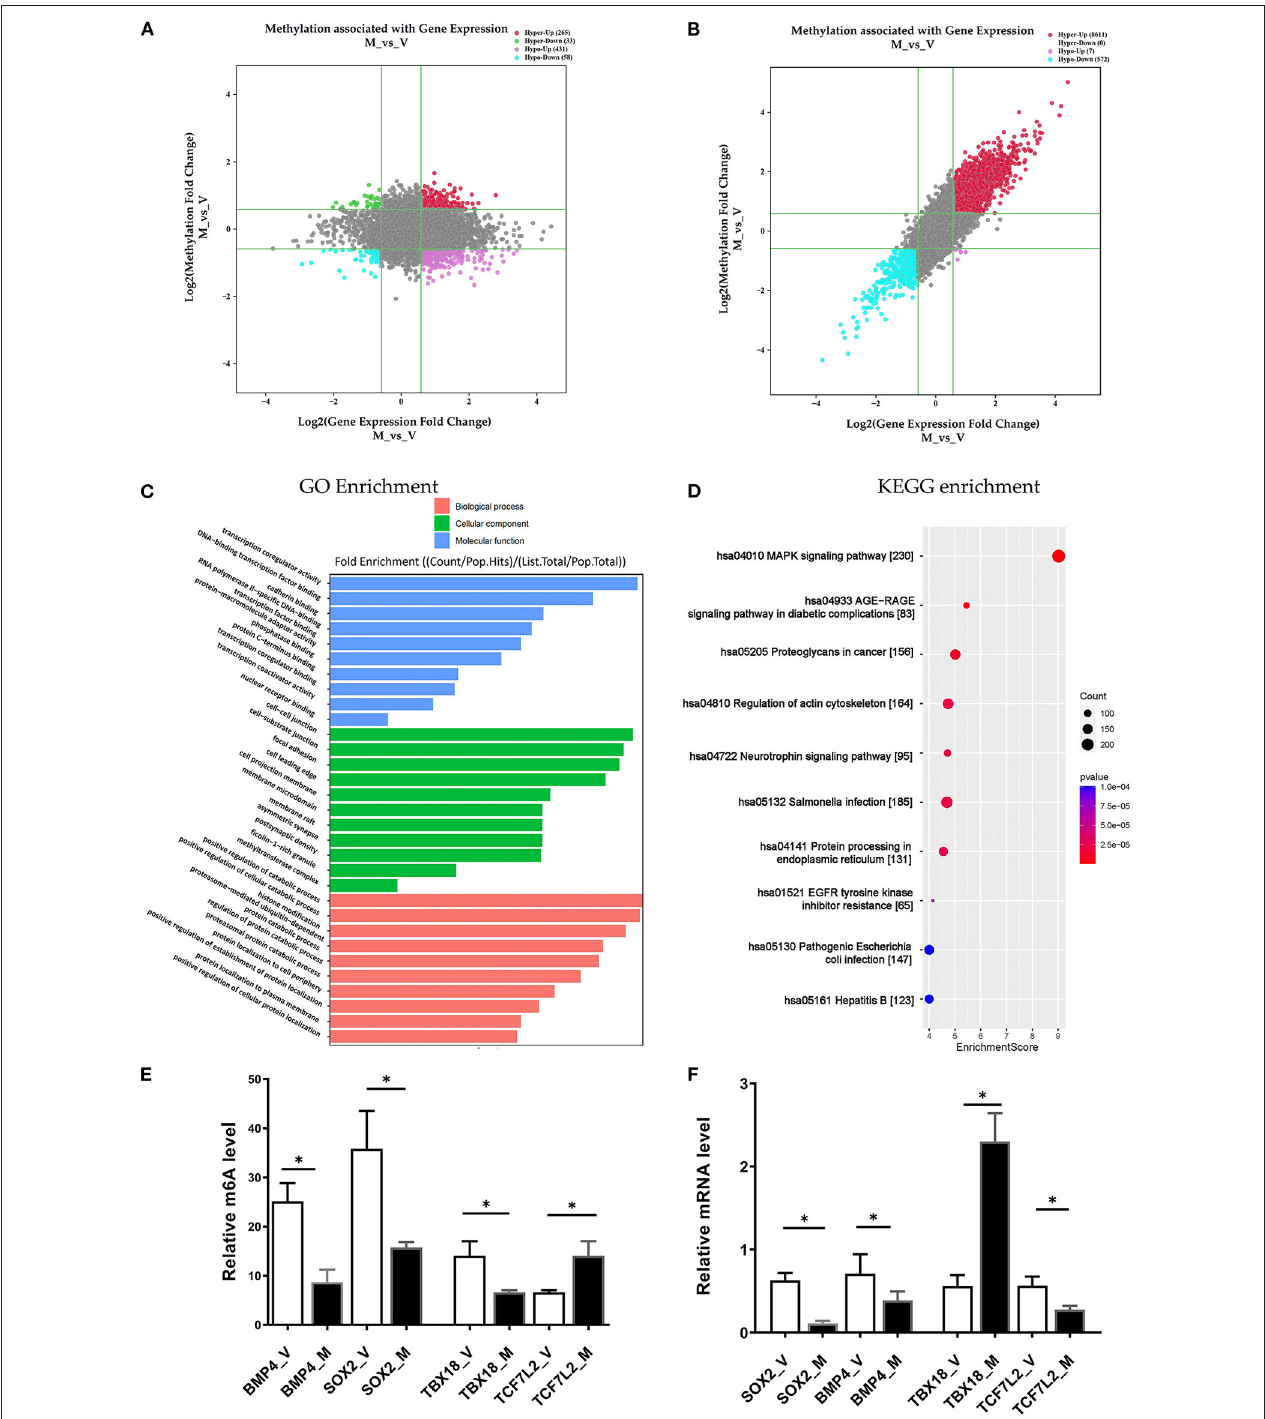
FIGURE 5 | Conjoint analysis of m 6 A methylation and mRNA expression in different ureteral phenotypes. (A) Four-quadrant plot indicating the differentially methylated peaks within differentially expressed mRNAs (log2 FC > 0.5, P < 0.05). (B) Dot plot of Log2 fold change (FC) (mRNA expression) vs. Log2 FC (differential m 6 A methylation) revealing a positive association between total m 6 A methylation and level of mRNA expression (Pearson R 2 = 0.20, P < 0.05). (C,D) Enrichment analyses of mRNAs with both differential methylation and expression via Gene Ontology (GO) and Kyoto Encyclopedia of Genes and Genomes (KEGG). (E) MeRIP-qPCR validation of m 6 A level changes in four hyper-methylated or hypo-methylated genes in megaureter group (M) and vesicoureteral reflux (VUR) group (V) samples. (F) Relative mRNA levels of four genes were assessed by real-time PCR in megaureter group (M) and vesicoureteral reflux (VUR) group (V) samples. Data are expressed as mean ± SD; data were analyzed using the nonparametric t -test. * P < 0.05; M group vs. V group ( n = 6 per group). Hypo, hypomethylation; Hyper, hypermethylation; Up, upregulated expression; Down, downregulated expression.